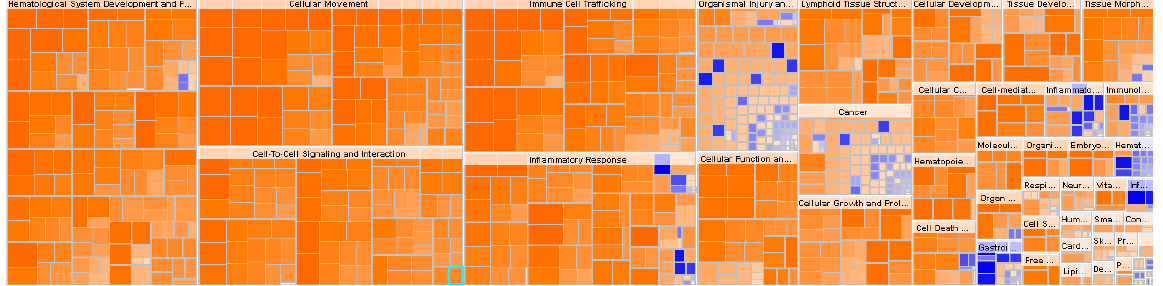
Figure 4. Functional category annotation analysis of obese patients with T2D shows a significant enrichment of hematological system development and function, cellular movement, immune cell trafficking and cell-to-cell signaling and interaction, inflammatory response and cellular functions and maintenance. Blue color indicates inhibition; red color indicates activation.